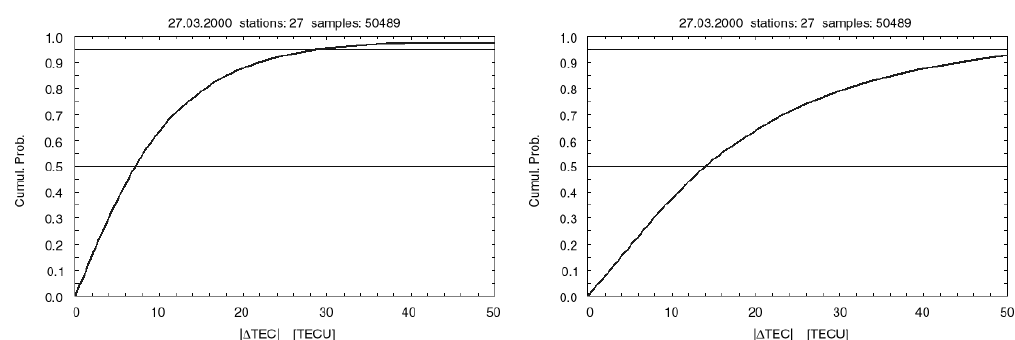
Fig. 4. Cumulative distributions of the absolute values of the differences between experimental and recon- structed slant TEC data corresponding to 27 IGS stations homogeneously distributed in Modip, for the day 27 March 2000. In the first case ( left panel) the modeled slant TEC were reconstructed using NeQuick driven by Az grids derived from La Plata vertical TEC maps. In the second case ( right panel) the modeled slant TEC data were calculated using NeQuick driven by the solar flux of the